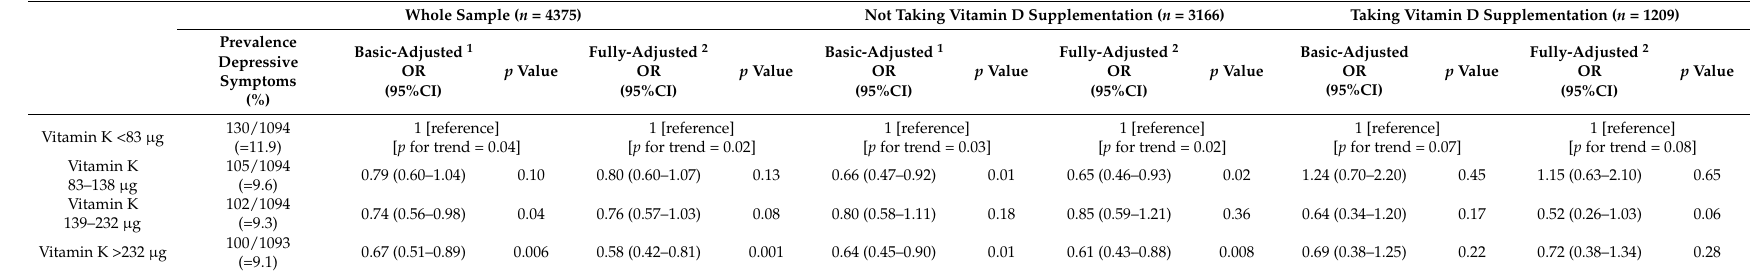
Table 2. Association between dietary vitamin K intake and depressive